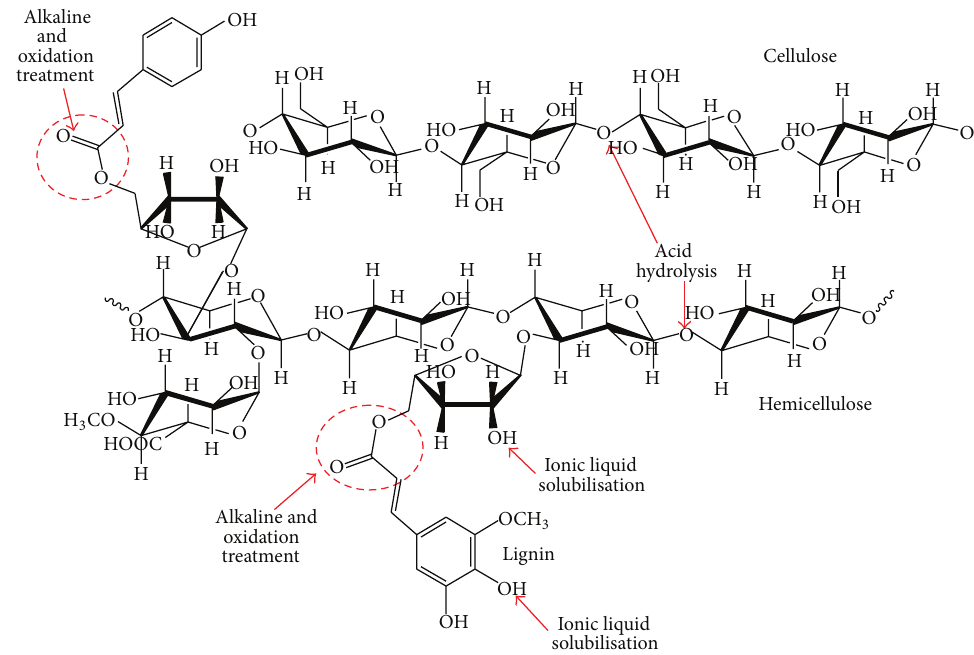
Figure 7: Selectivity of chemical treatments for fractionation of lignocellulosic biomass.